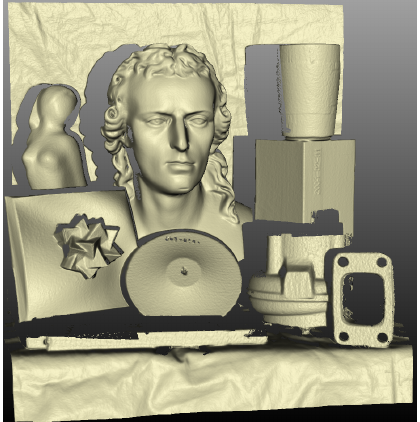
Figure 10. Ground truth 3D model calculated from 400 image